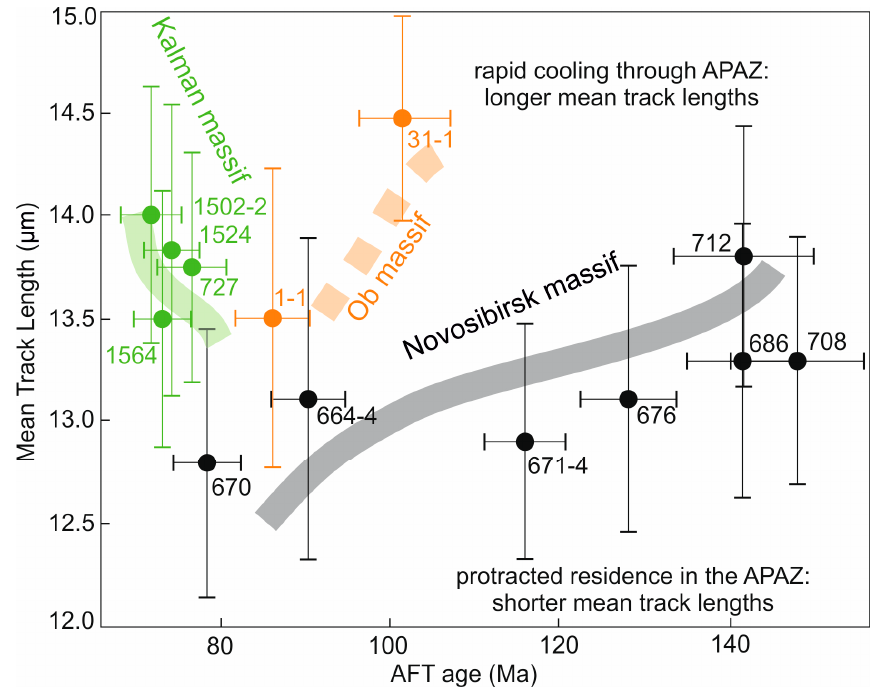
Figure 4. Boomerang plot of AFT data from the West Siberian Basin basement, with mean track length and age (incl. their uncertainty) displayed on the vertical and horizontal axis, respectively.